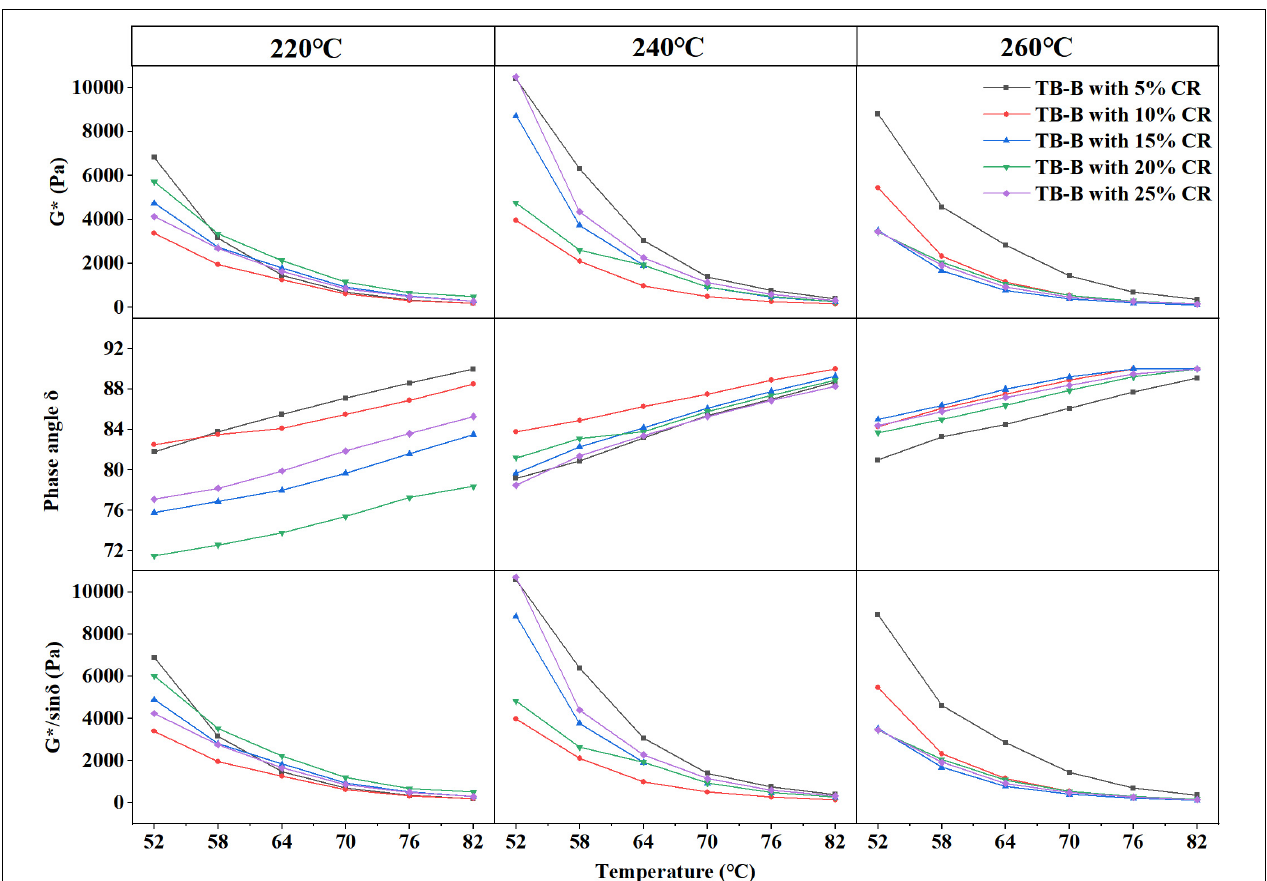
FIGURE 4 | G*, δ and G*/sin δ of